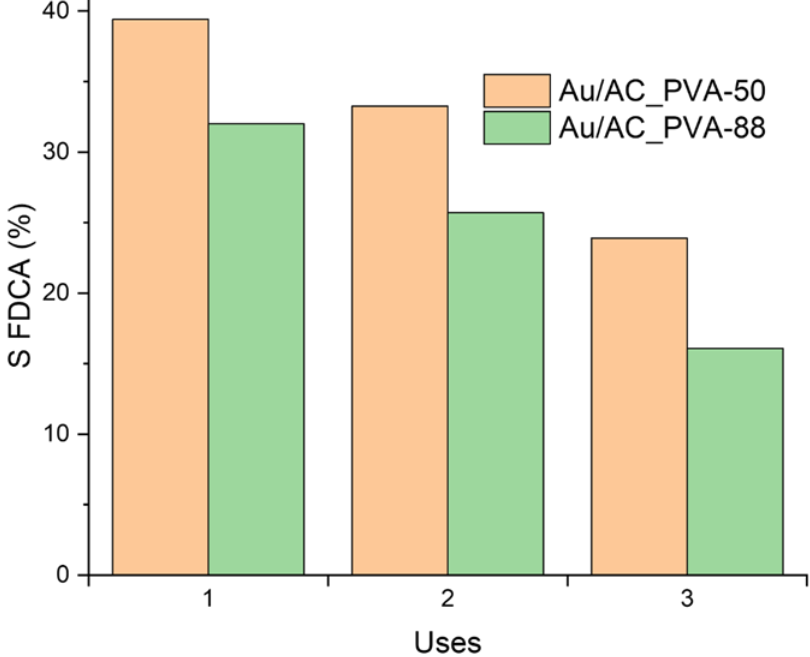
Figure 3. Reusability tests on HMF oxidation using two catalysts prepared with either a synthesized or a commercial polymer. Reaction conditions: T = 70 ◦ C, t = 2 h, P = 10 bar O 2 , molar ratios or a commercial polymer. Reaction conditions: T = 70 °C, t = 2 h, P = 10 bar O 2 , molar ratios HMF:Au:NaOH = HMF:Au:NaOH = 1:0.01:4.